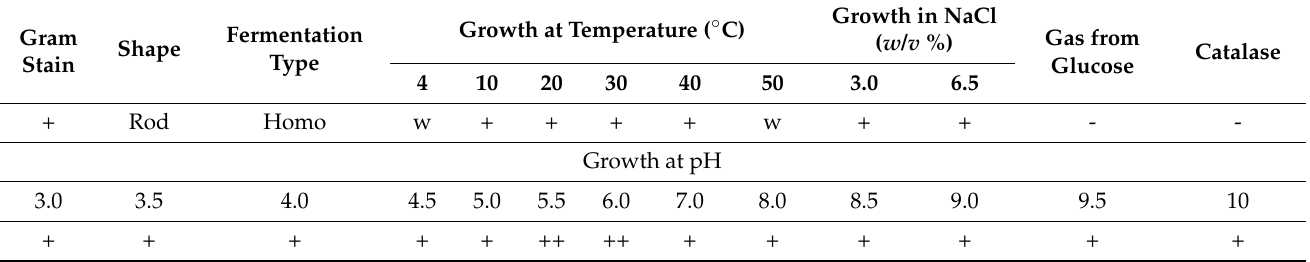
Table 1. The physiological and biochemical characteristics of